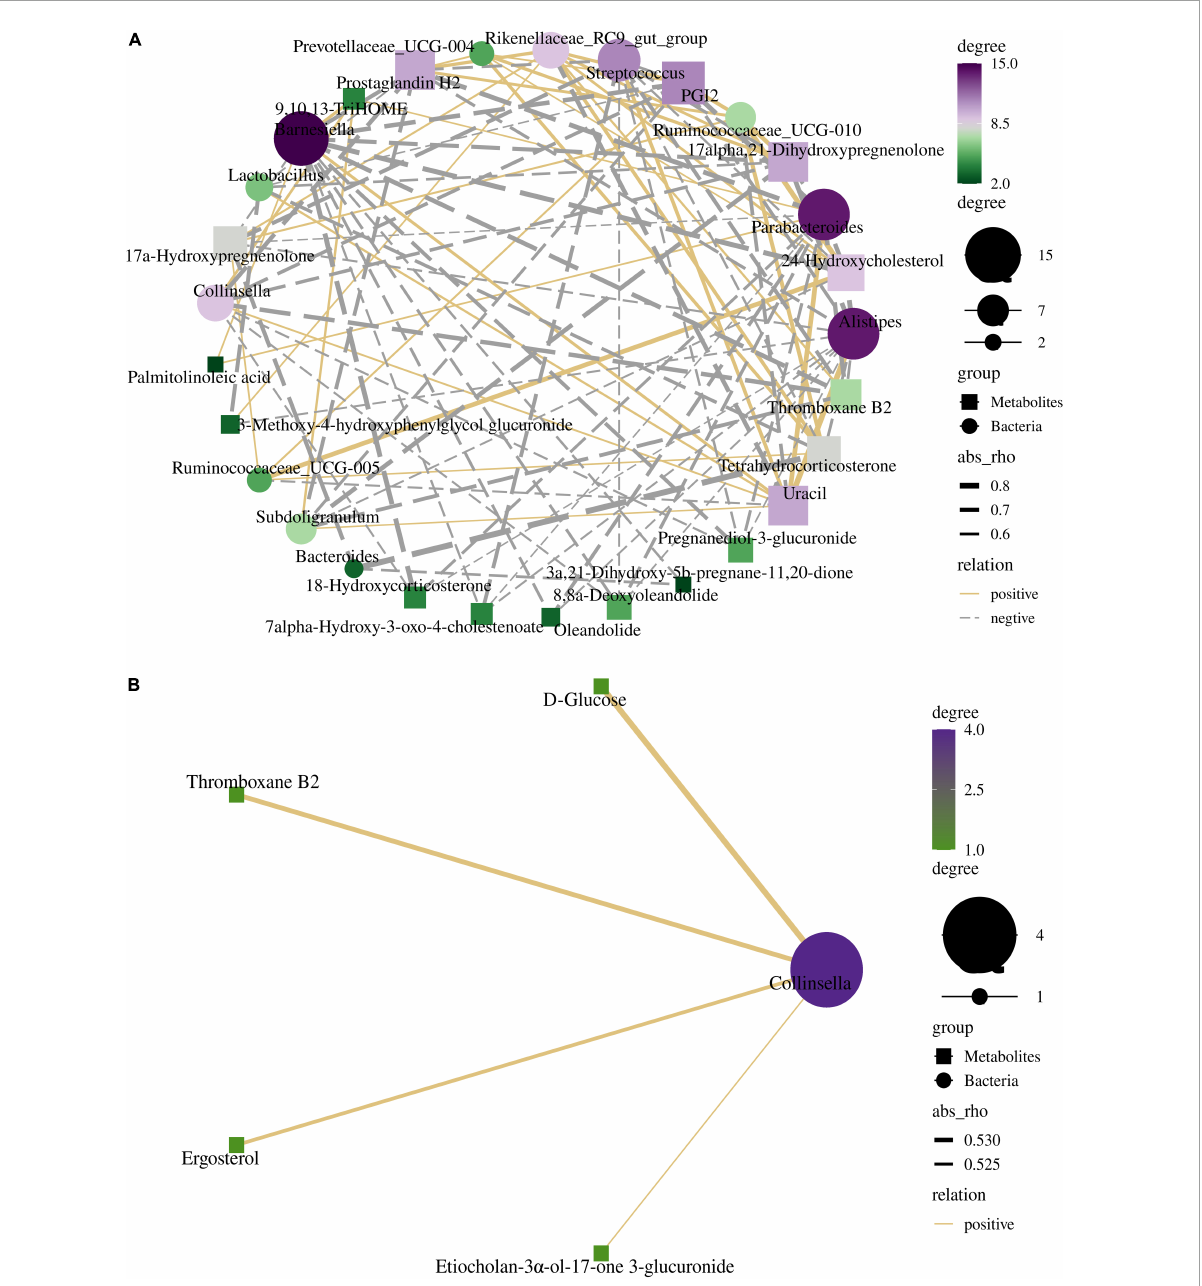
FIGURE7 The interactive network diagrams show the correlations between the bacteria and their metabolites in the cecum (A) and colon (B) . The size of each node is proportional to the number of related metabolites or microbiome. Circular nodes represent bacteria and diamond nodes represent metabolites. The width of the line indicates the strength of the correlations. The lines in yellow and gray denote positive and negative correlations,